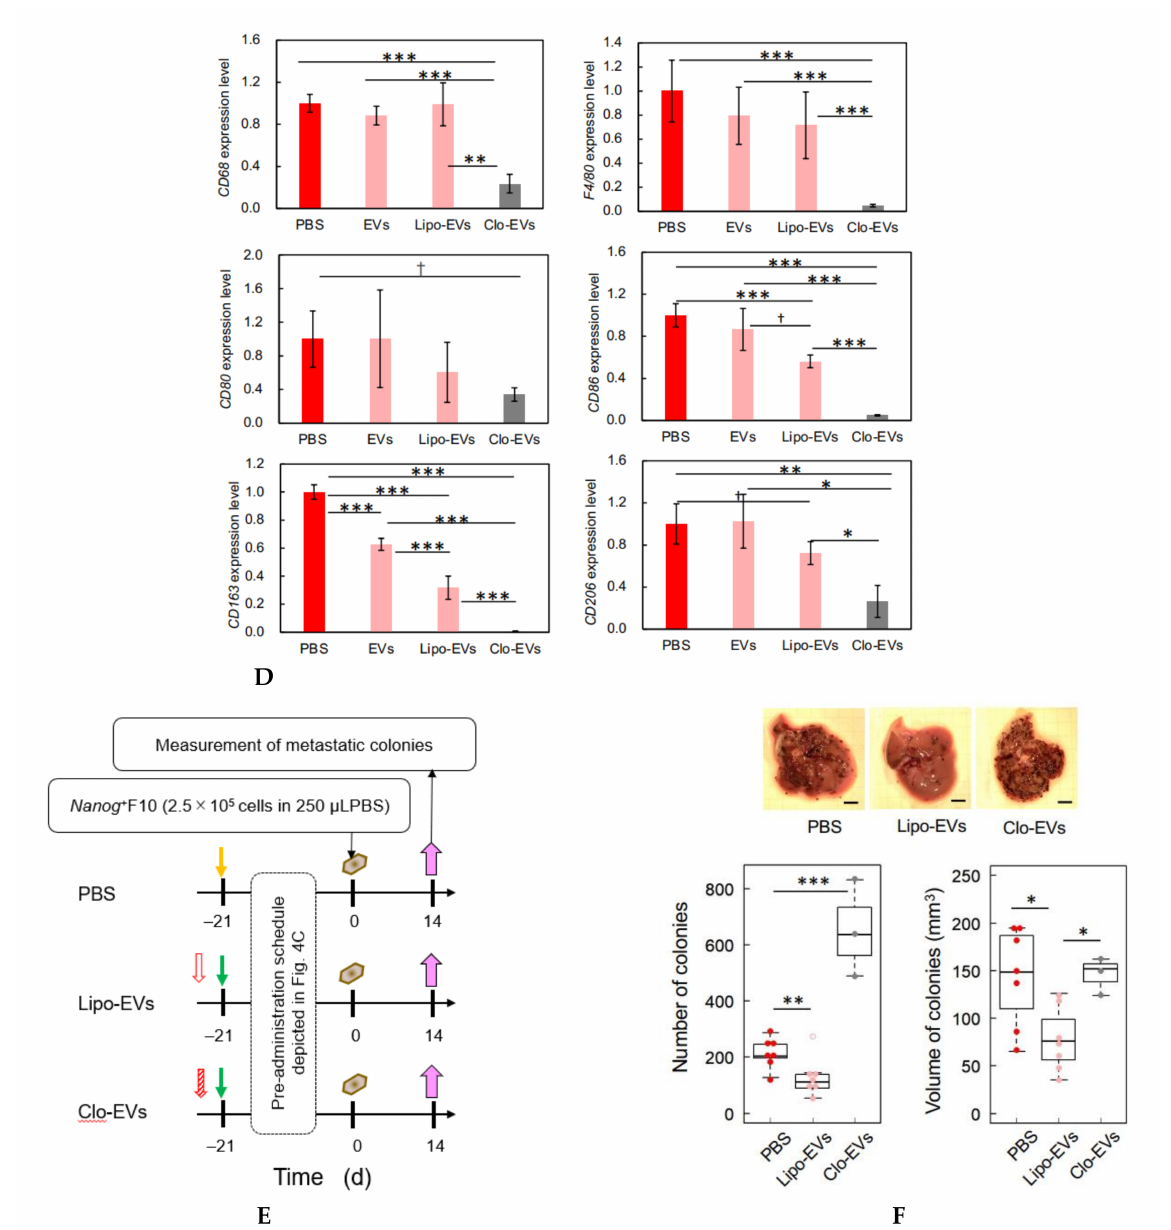
Figure 4. Involvement of macrophages in metastasis suppression by Nanog + F10-EVs. ( A ) Expression of CD68 in liver tissue slices and its depletion by clodronate treatment. PBS, treated with PBS; Clodronate, treated with clodronate at 12.5 mg/kg mouse body weight; Scale bar, 50 µ m. ( B ) Histo- chemical images of liver tissue sections obtained by HE staining. PBS and Clodronate, same treatment as Figure 4A. CV, central vein; Scale bar, 50 µ m.( C ) Schedule for the pre-administration of Nanog + F10- EVs with or without clodronate. PBS, control; EVs, Nanog + F10-EVs; Lipo-EVs, Nanog + F10-EVs with liposomes containing no clodronate; Clo-EVs, Nanog + F10-EVs with liposomes containing clodronate. Orange arrow, injection of 100 µ L PBS as a control; green arrow, injection of 100 µ L PBS containing 5 µ g Nanog + F10-EVs; unfilled red arrow, injection of PBS (in the range of 150–200 µ L) containing liposome (62 mg/kg mouse weight) used as a carrier of clodronate; diagonally hatched red arrow, injection of PBS (in the range of 150–200 µ L) containing liposome (l62 mg/kg mouse weight) and clodronate (12.5 mg/kg mouse weight); blue arrow, removal of livers. ( D ) Expression of macrophage markers in livers removed on 0 d and analyzed by quantitative RT-PCR. mean ± SD for n = 3, n = 2 ( CD80 expression for Clo-EVs group). Refer to the legend for Figure 4C about PBS, EVs,